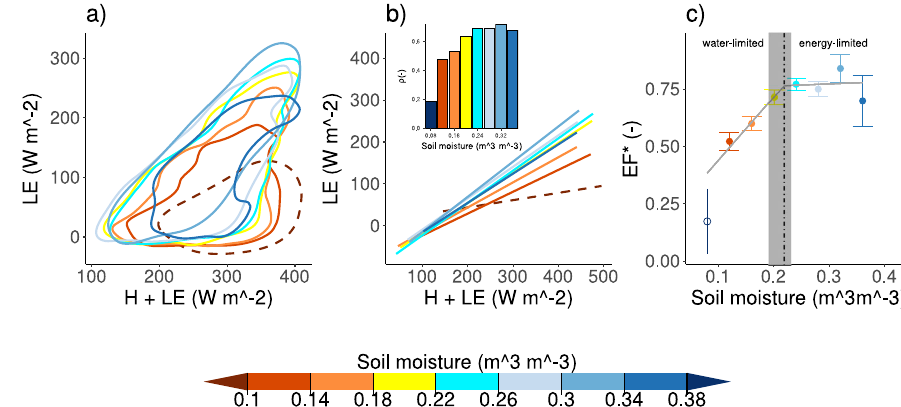
Fig. 3 Soil moisture control on landscape-scale surface fl ux partitioning. a Surface energy fl ux estimates from CLASS4GL. Point clouds illustrated through 80th percentile contour lines and colored according to independent, satellite-derived soil moisture (SM) observations 41 . b Least-squares regression fi ts (full lines indicate statistical signi fi cance, p < 0.05), with corresponding correlations ( ρ ) in the inset. c Relation between the slope of the linear models (EF * , see text) with SM (full dots indicate statistical signi fi cance, p < 0.05). Error bars show the standard deviation of EF * . Dark-grey solid lines result from a piecewise linear regression between SM and EF * with according to breakpoint (dot-dashed) and interquartile range from bootstrapping (light-grey